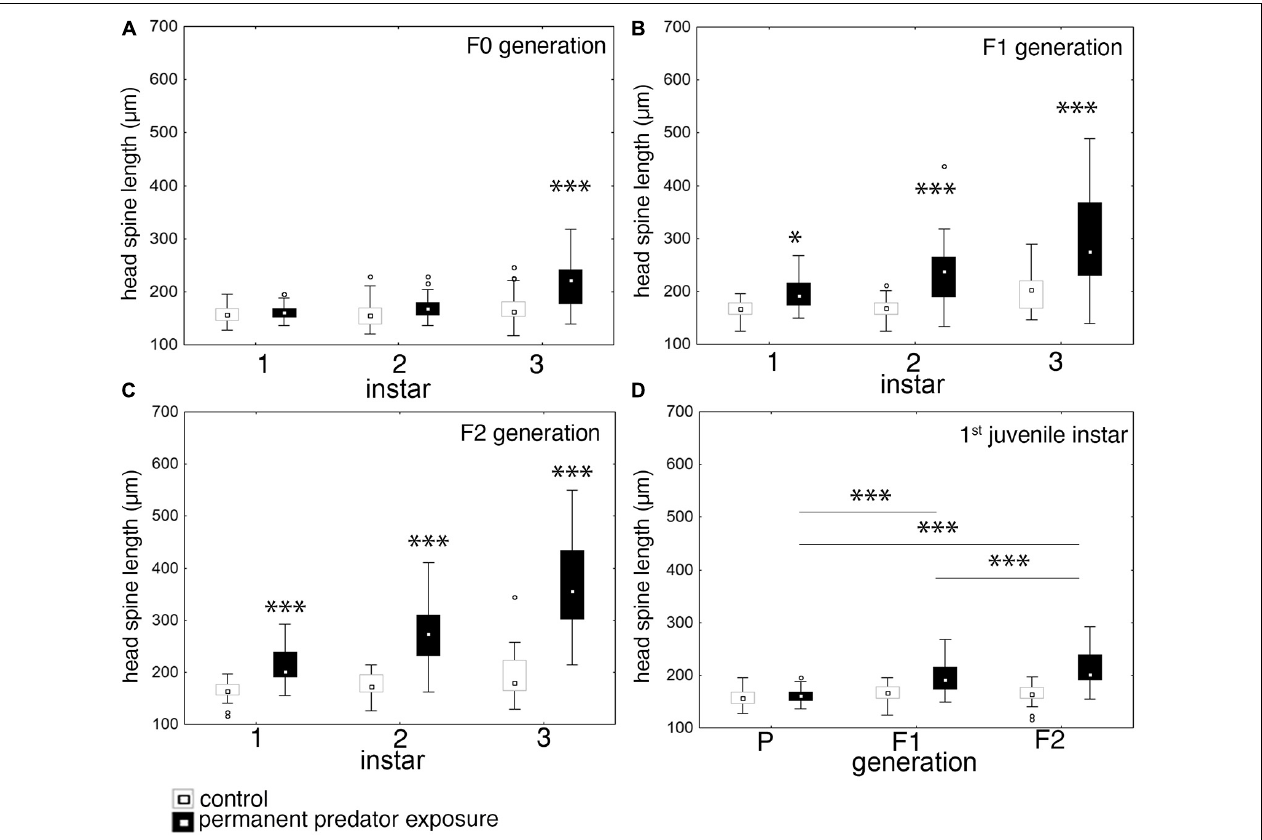
FIGURE 2 | Effect of permanent predator exposure on head spine length in D. lumholtzi. (A) F0 generation: head spine length in the first three juvenile instars in control and permanently fish exposed D. lumholtzi ; ANOVA: F ( 2 , 203 ) = 11.466, P ≤ 0.001. (B) F1 generation: head spine length in the first three juvenile instars in control and permanently fish exposed D. lumholtzi ; ANOVA: F ( 2 , 237 ) = 10.064, P ≤ 0.001. (C) F2 generation: head spine length in the first three juvenile instars in control and permanently fish exposed D. lumholtzi ; ANOVA: F ( 2 , 199 ) = 25.83, P ≤ 0.001. (D) Head spine length in the first juvenile instar in control and permanently fish exposed D. lumholtzi across the P, F1, and F2 generation. ANOVA: F ( 2 , 249 ) = 17.77, P ≤ 0.001. Displayed are medians (square), midspread 50% (box) and the 25th percentile (lower whisker); 75th percentile (upper whisker), with outliers (circles). ∗ P ≤ 0.05; ∗∗∗ P ≤ 0.001. Bonferroni post hoc analysis in Supplementary Tables 1–6